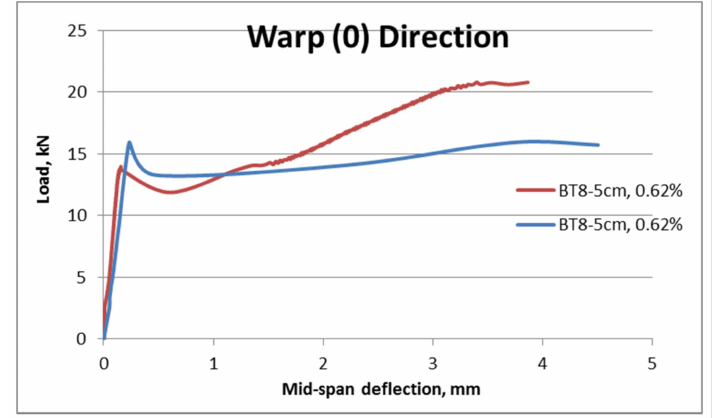
Figure 12. Mid-span load-deflection of TRC beams with woven fabric (5 cm) at warp